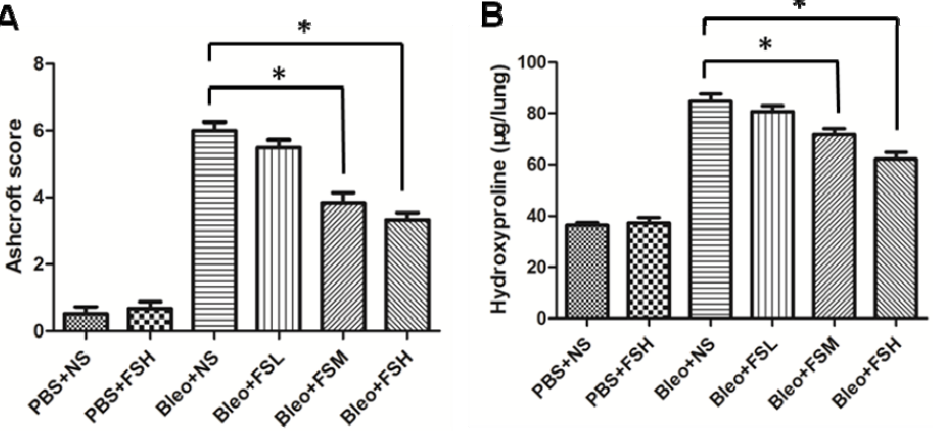
Figure 2. Evaluation of fibrotic changes by Ashcroft score ( A ) and hydroxyproline content ( B ) on day 21 after bleomycin administration. Results are expressed as means ± standard error of the mean (SEM) ( n = 6). Statistical analysis was performed using one-way analysis of variance (ANOVA) followed by Tukey’s multiple comparison test (* p <